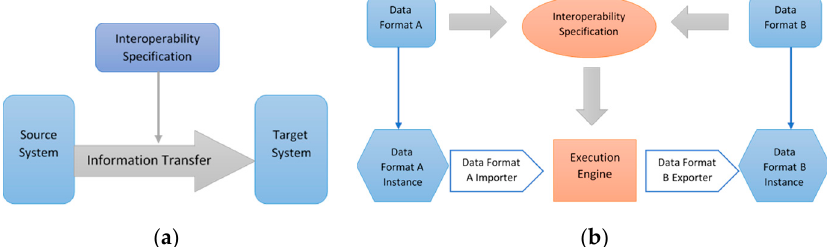
Figure 1. Plug’n’Interoperate Architecture: ( a ) Interoperability Specifications; ( b ) Interoperability